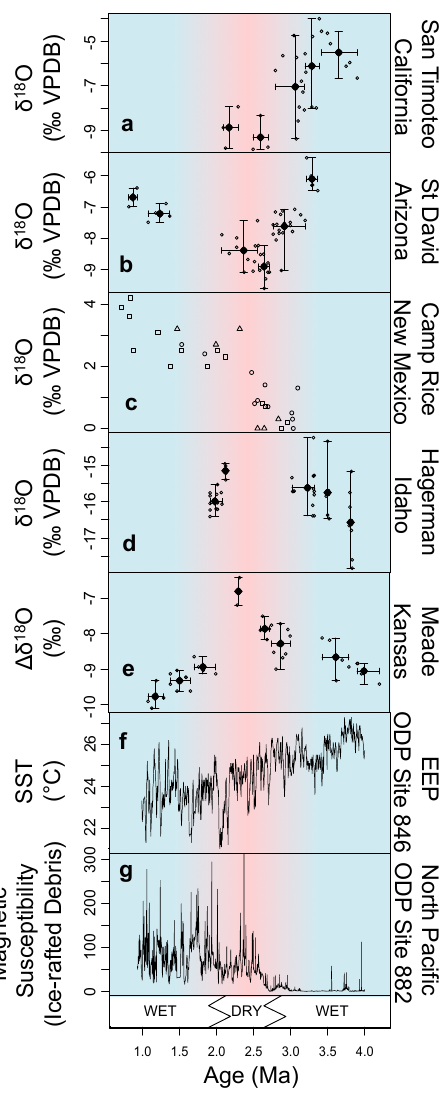
Fig. 3. Isotope stratigraphies from (a) San Timoteo, CA, (b) St David, AZ (Wang et al., 1993), (c) Camp Rice, NM (Mack et al., 1994), (d) Hagerman, ID, and (e) Meade, KS (Fox and Koch, 2003). Open circles in (a – d) represent individual samples, filled cir- cles binned averages, and error bars bin ranges. Camp Rice, NM, values normalized to sub-locality minimum values, and circles, tri- angles, squares represent sub-localities Hatch Siphon, Rincon Ar- royo, Lucero Arroyo, respectively. (f) Reconstructed SSTs in the east equatorial Pacific ODP Site 846 show development of the mod- ern cold tongue (Lawrence et al., 2006). (g) Magnetic susceptibility at ODP Site 882 in the North Pacific shows ice-rafted debris and expansion of NH glaciation through the Pleistocene (Maslin et al., 1995). Climatic conditions (wet/dry) in the western US are shown at the bottom and in blue and red background based on compilation of proxy-based reconstructions (Thompson,